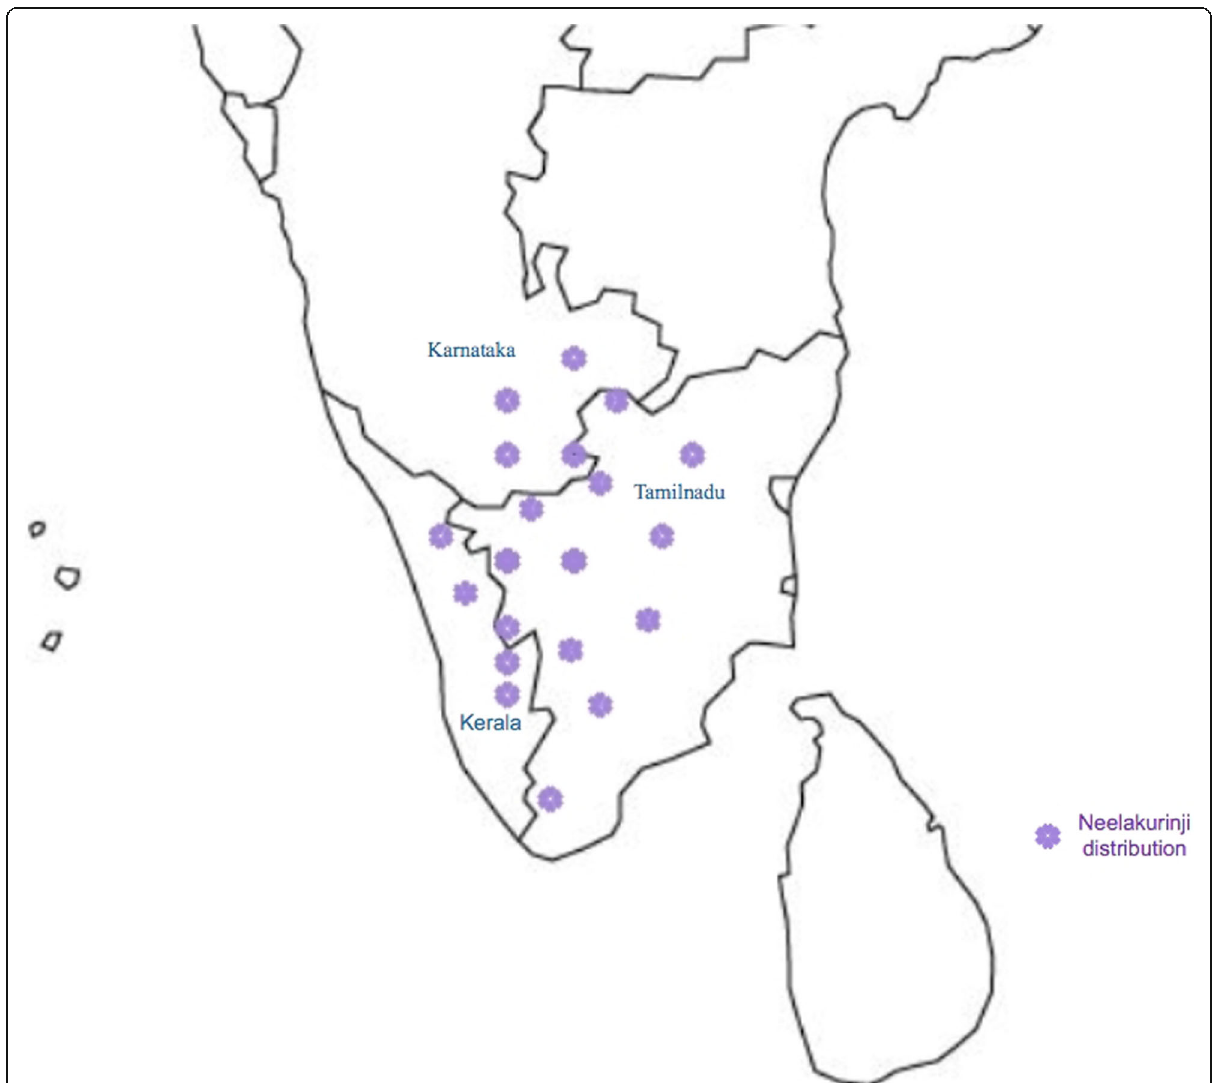
Fig. 1 Distribution of Neelakurinji ( Strobilanthes Kunthianus Nees T Anders.) (Photograph is not in scale) ( Source : unpublished photograph of Soumen